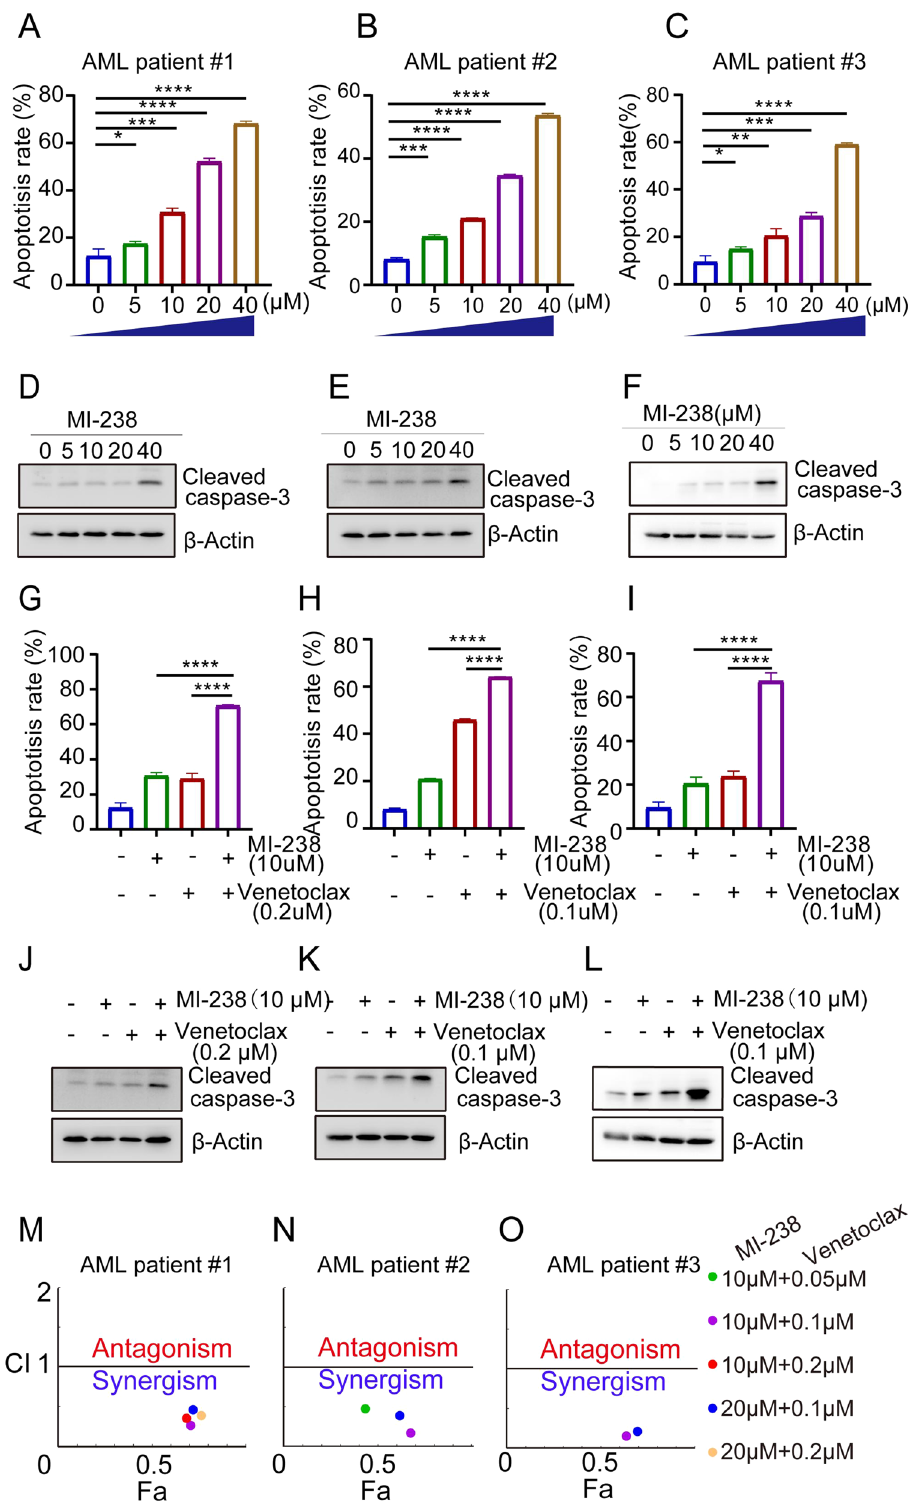
Fig. 7 MI-238 treatment alone or in combination with venetoclax effectively induces apoptosis in primary patient AML cells. Bone-marrow mononuclear cells from three different AML patients were treated as indicated for 48 h, and the apoptosis were measured by annexin V staining ( A – C ; G – I ) or western blot analysis of caspase 3 cleavage ( D – F ; J – L ). The combination index (CI) was calculated by CompuSyn software ( M – O ). Data represent mean SD. * P < 0.05, ** P < 0.01, *** P < 0.001, and **** P < ±